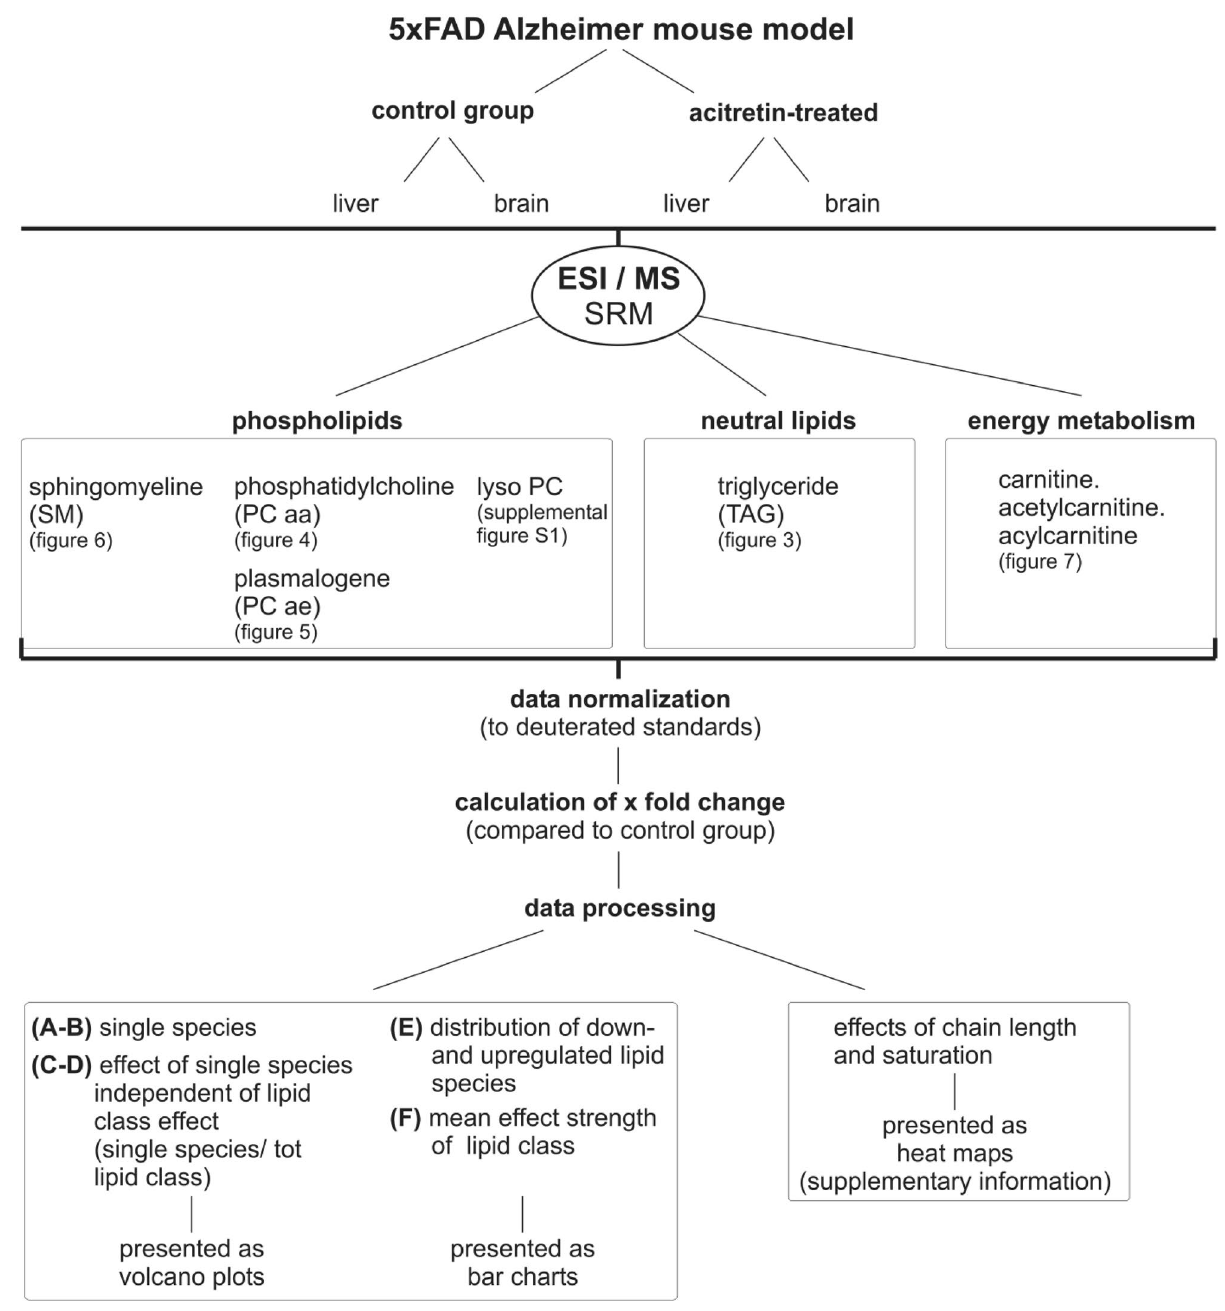
Figure 1. Schematic overview of the study design. FAD: Familial Alzheimer´s Disease. ESI/MS SRM: Electrospray Ionisation/Mass Spectrometry Selected Reaction Monitoring. Tot: